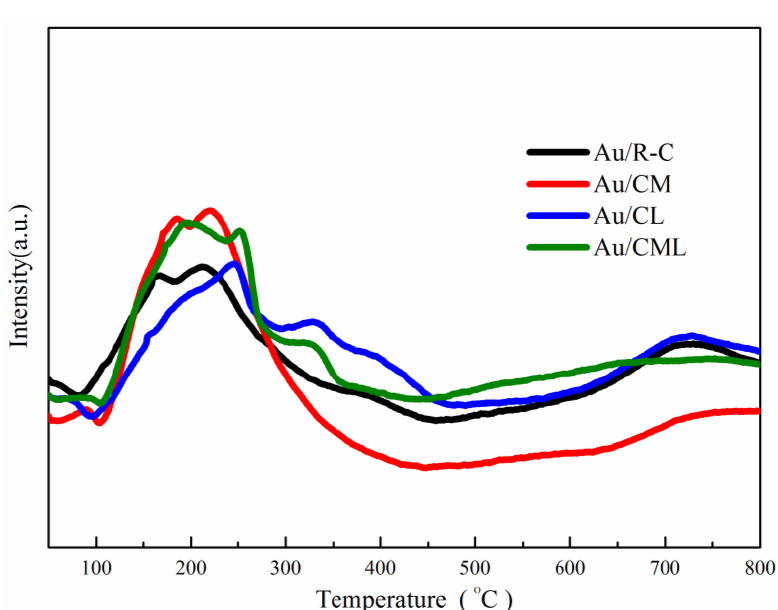
Figure 6. H 2 - TPR profiles of catalysts . Figure 6. H 2 -TPR profiles of catalysts. Table 3. Surface basicity of the